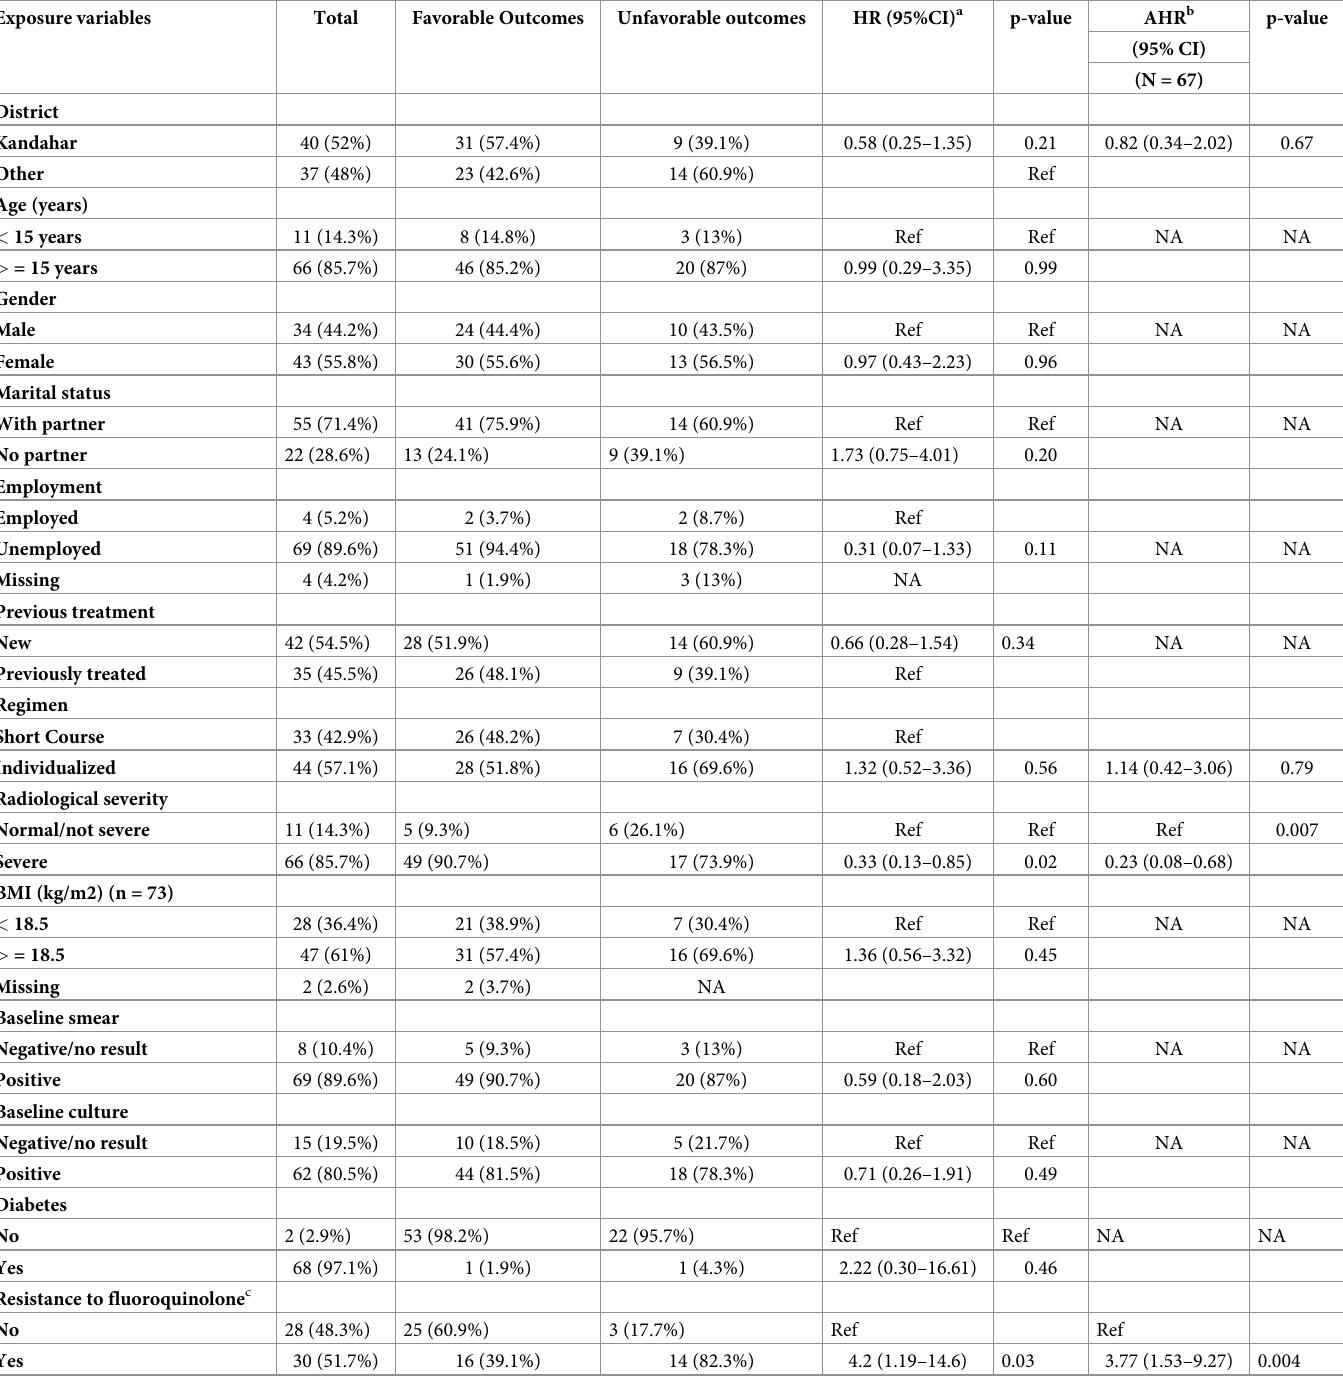
Table 7. Associations of participants characteristics with favourable and unfavourable outcomes (death and lost to follow-up). Exposure